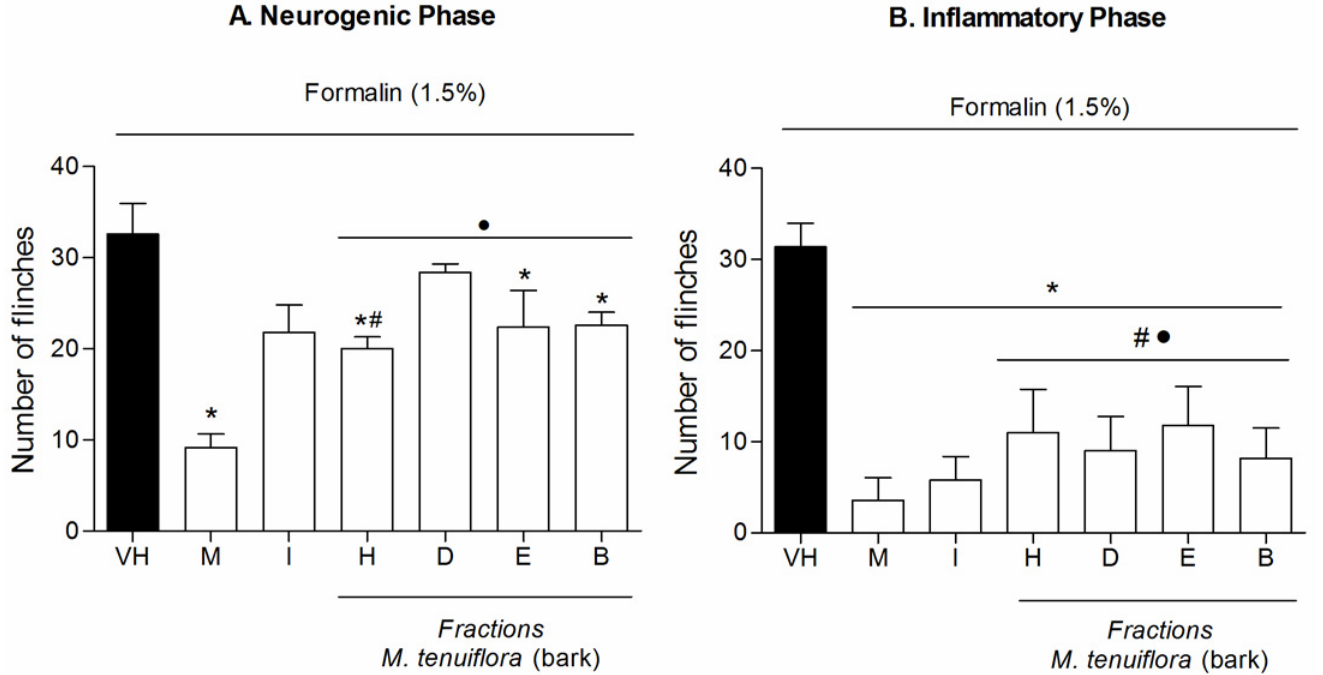
Fig 12. Effect of the hexane (H), DCM (D), EtOAc (E) and BuOH (B) M . tenuiflora bark extract fractions on the nociception induced by intraplantar formalin injection in mice. Neurogenic phase (Fig 12A) and inflammatory phase (Fig 12B). Morphine (M, 5 mg/kg, s.c.) and indomethacin (I, 10 mg/kg, i.p.) were the positive control groups. The fractions were tested at 100 mg/kg. VH is the vehicle group (negative control). The results are presented as the mean ± S.D. (n = 8). Statistical significance was calculated by ANOVA followed by Bonferroni's test. * P < 0.05 compared to the vehicle-negative control treated group. # P > 0.05 compared to the morphine-treated group. (cid:129) P > 0.05 compared to the indomethacin-treated